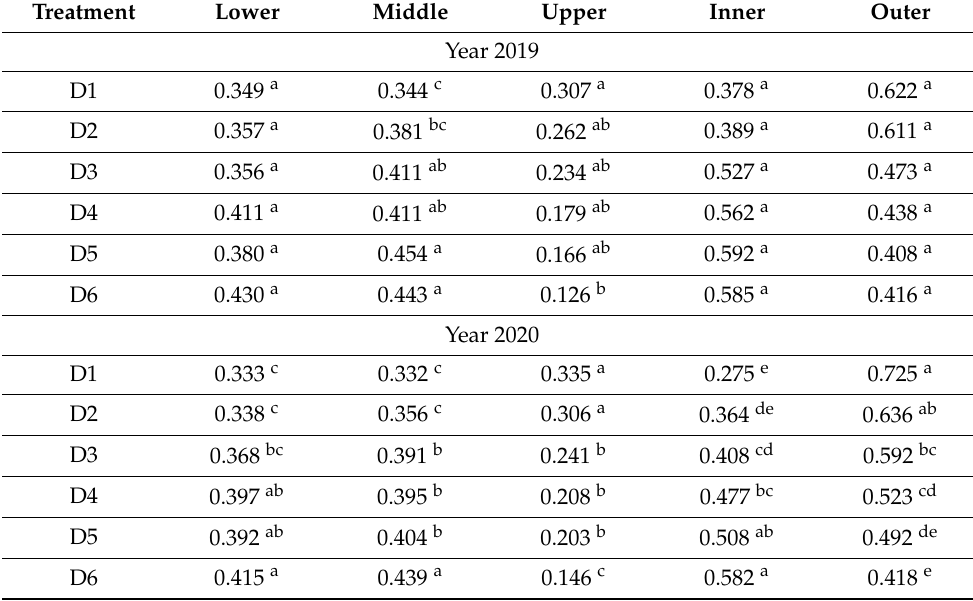
Table 6. The shedding rate of different sections with different densities in 2019 and 2020. Treatment Lower Middle Upper Inner Outer Year 2019 D1 0.349 a 0.344 c 0.307 a 0.378 a 0.622 a D2 0.357 a 0.381 bc 0.262 ab 0.389 a 0.611